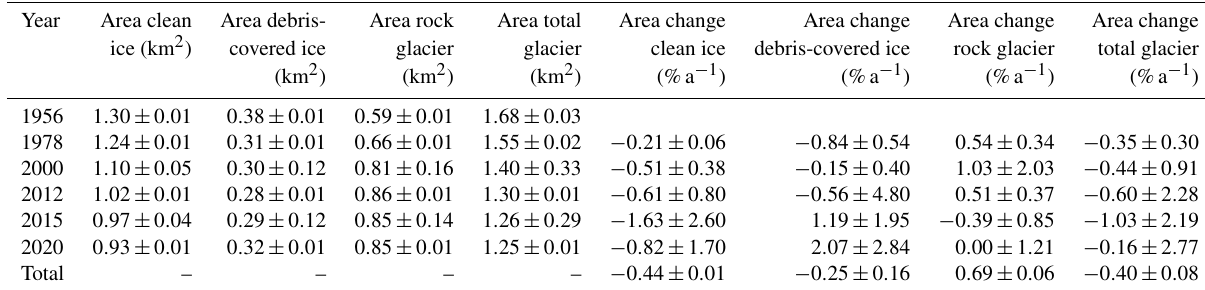
Figure 3. (a) Change in area for Tapado Glacier, both for clean ice (dashed lines) and total glacier area (solid lines), between 1956 and 2020. Background imagery is a Pléiades scene from 2020, © CNES (2018) and Airbus DS (2018), all rights reserved. (b) Orthoimage and glacier outline from 1956. (c) Subset of the debris-covered tongue of Tapado Glacier (outline between debris-covered ice and rock glacier shown in black) with surface elevation changes between 2012 and 2020 shown. Table 3. Areas for the clean ice, debris-covered, and rock glacier components of Tapado Glacier between 1956 and 2020. Note that “total glacier” refers to the combined area of the clean ice and debris-covered ice